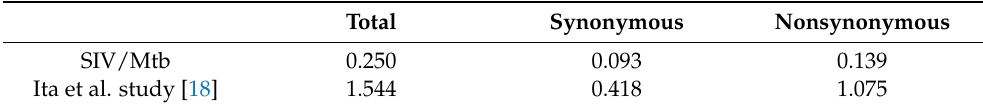
Table 1. Comparison of diversity of the SIV challenge stocks used in this study (SIV/Mtb) and in the Ita et al. [19]